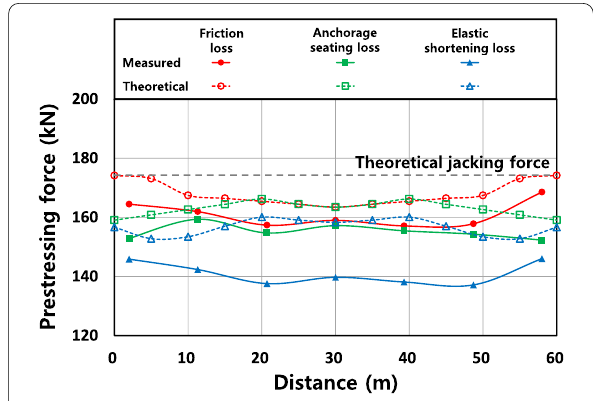
Fig. 10 PF distribution in girder 2 of bridge